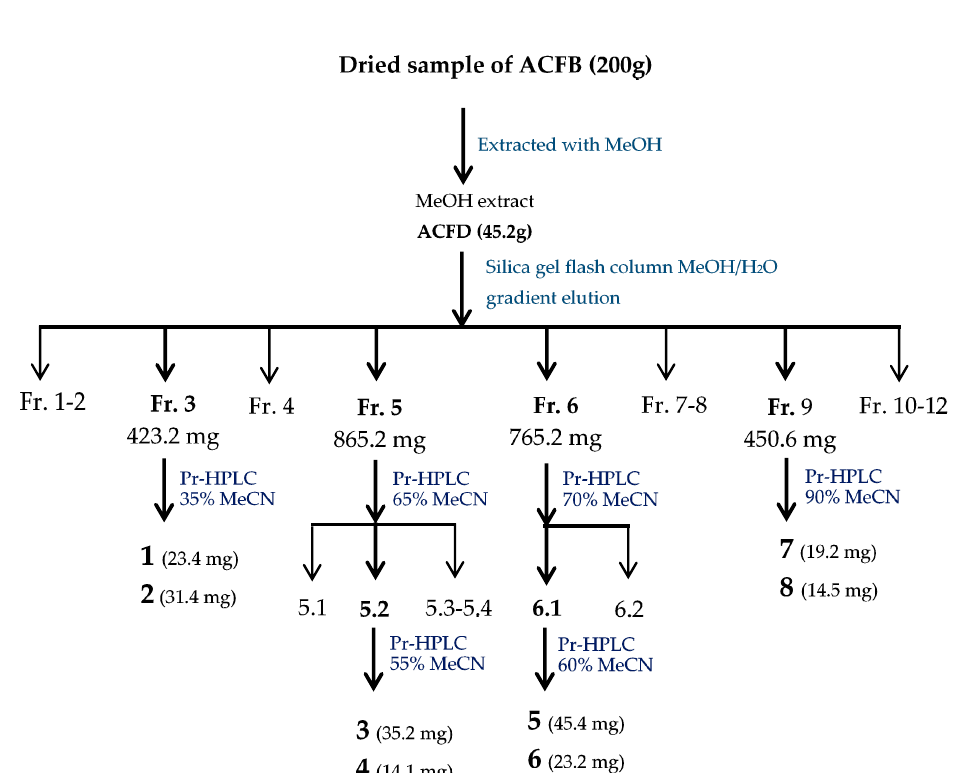
Figure 1. Flow chat of the purification process of active compounds from Antrodia cinnamomea fruiting bodies (ACFB) extract.